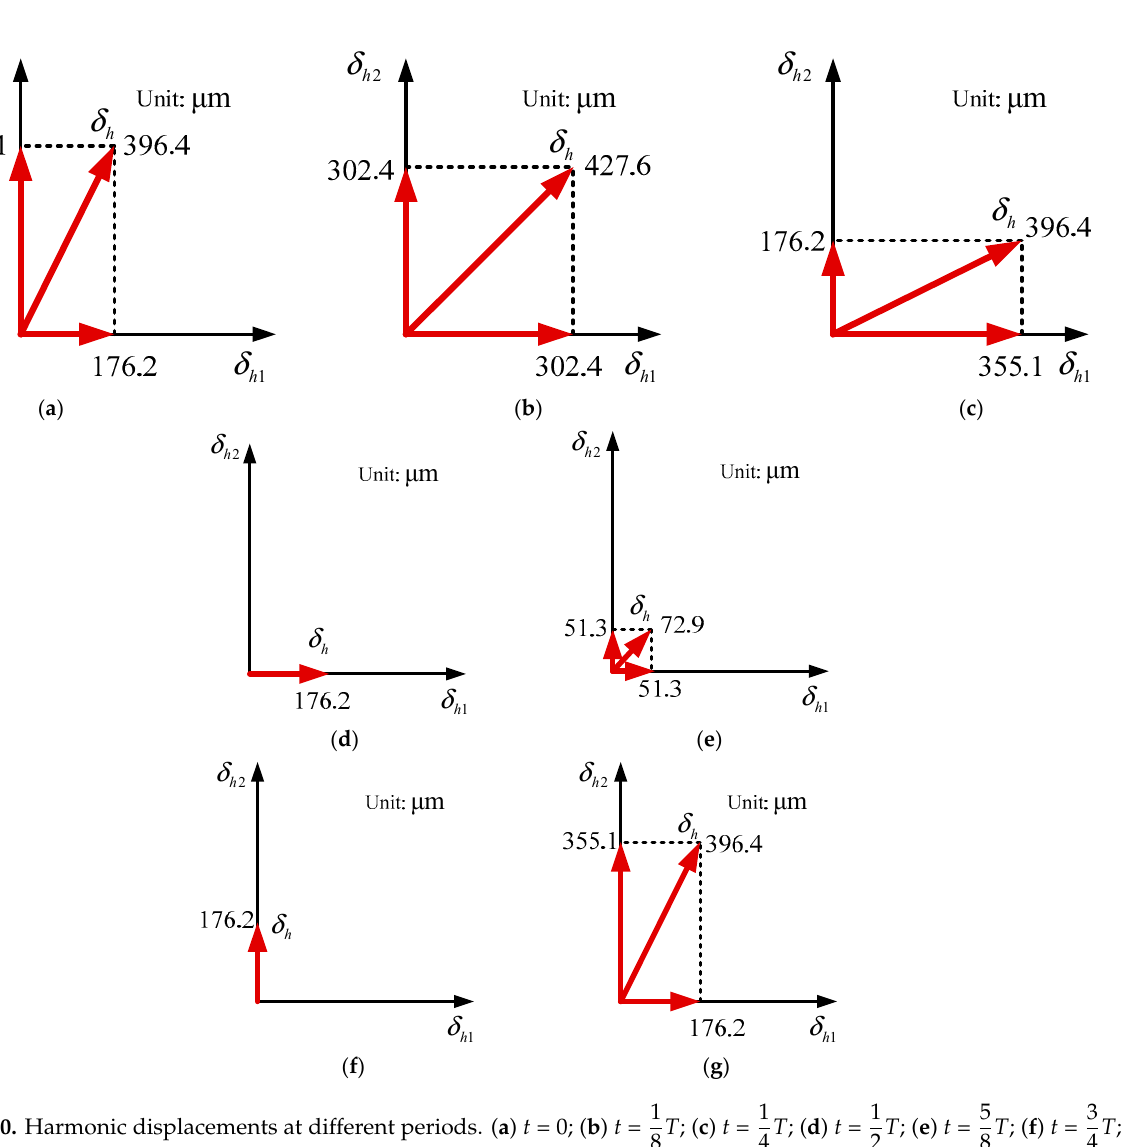
Figure 9. Calculation results of harmonic displacement. ( a ) Output harmonic displacement in both directions; ( b ) Total harmonic displacement; ( c ) Harmonic displacements that vary with time and voltage; ( d ) Comparison of total displacement and unidirectional displacement.